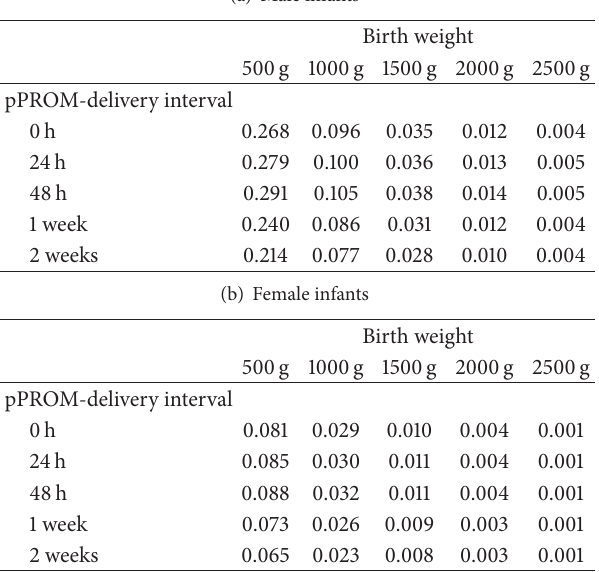
Table 4: Regression analysis of the impact of different birth weights and preterm premature rupture of membranes- (pPROM-) delivery intervalsonperiventricularleukomalaciarisk,assumingfetalweight gains of 0 g in 24 h and 48 h, 200 g in 1 week, and 400 g in 2 weeks [26]. Data are estimated incidence of periventricular